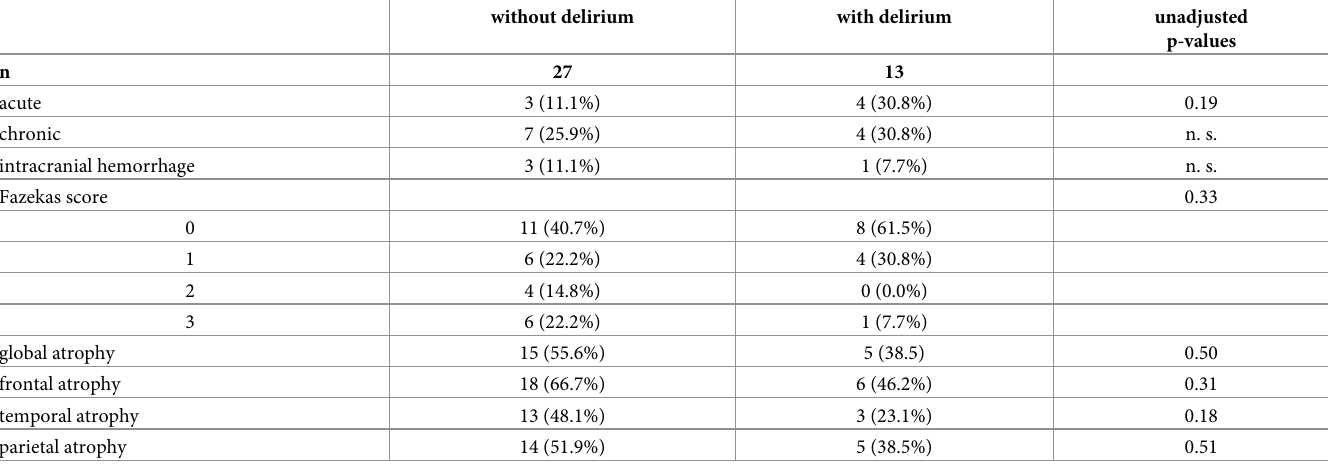
Table 4. Neuroradiological patient characteristics stratified by the presence of